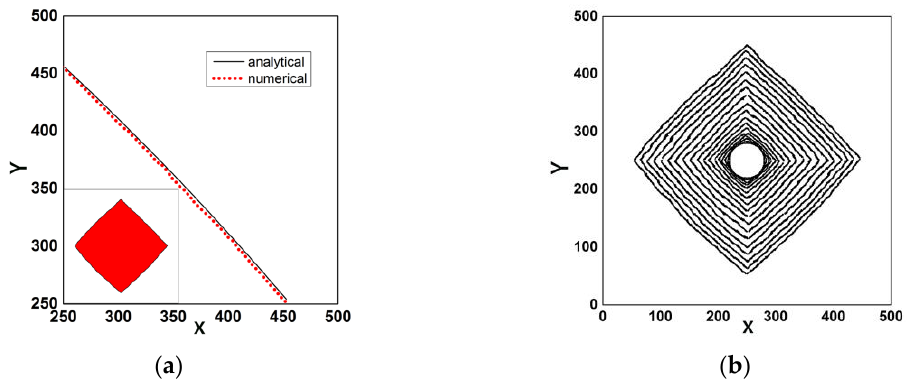
Figure 3. Simulation results for ε = 0.5 . ( a ) numerical equilibrium shapes and comparison of numerical and analytical interface positions; ( b ) isochorones of interface at every 2000 time steps.